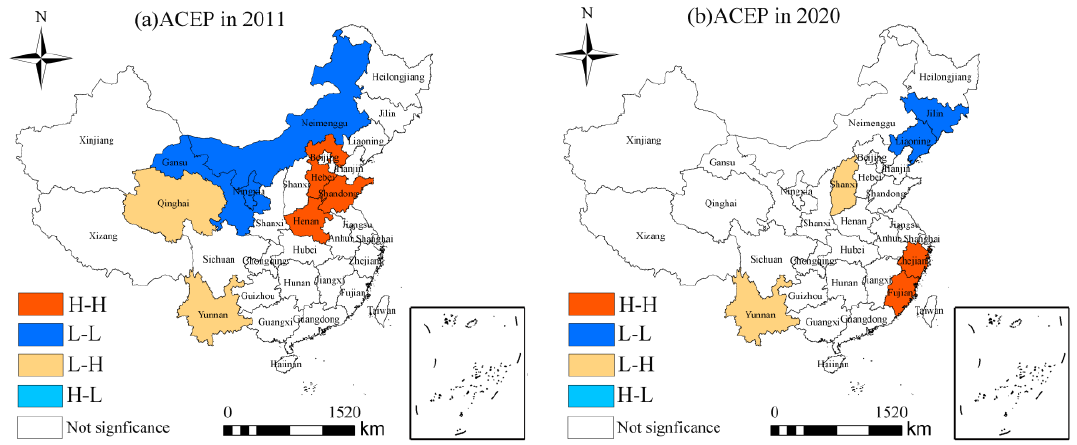
Figure 6. LISA map of ACEP in 2011 and 2020.